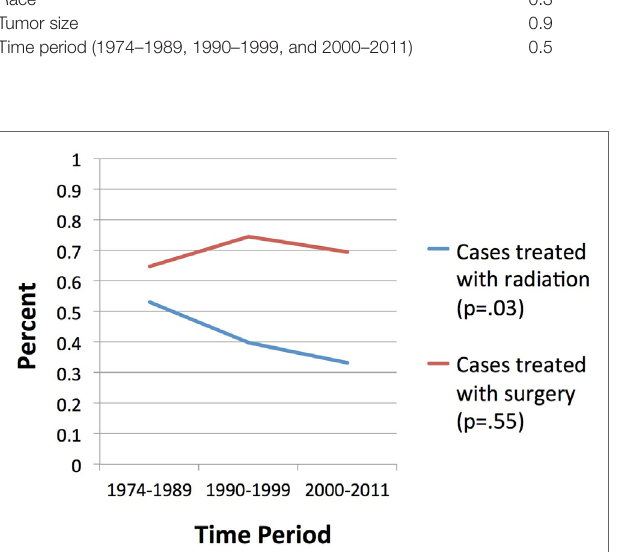
FigUre 1 | Trends in surgery and radiotherapy use .